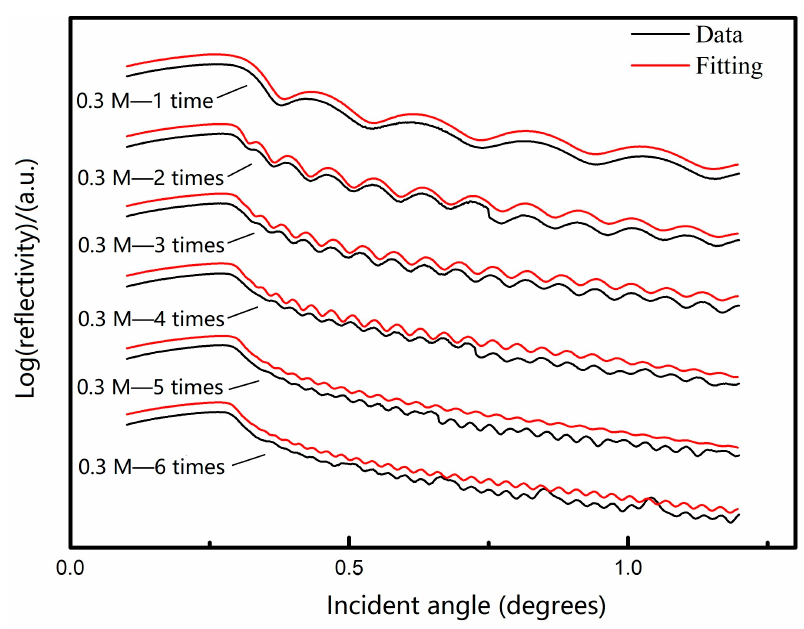
Figure 1. X-ray reflectivity measurements of 0.3 M precursor-based ZrO 2 films of different coating times. Table 1. The density, thickness and roughness of 0.3 M precursor-based ZrO 2 films of different coating times. The roughness for glass substrate is 0.79 ± 0.32 nm.